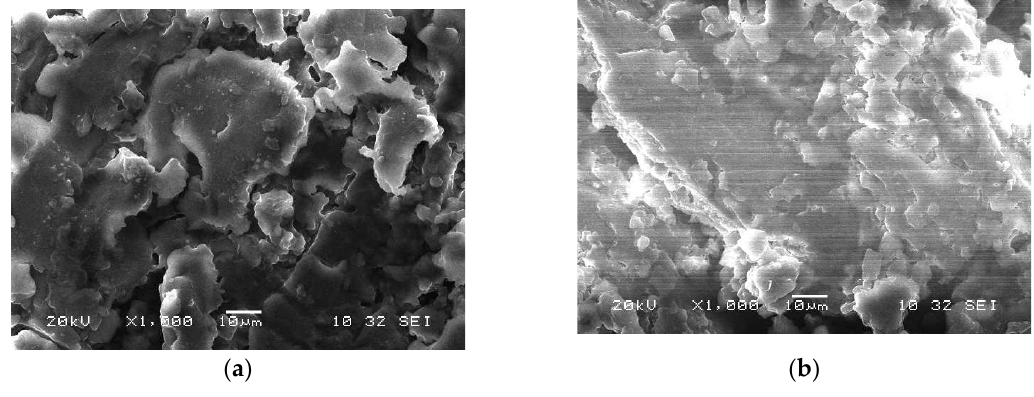
Figure 2. SEM technique images of the DSP surface ( a ) before and ( b ) after adsorption.